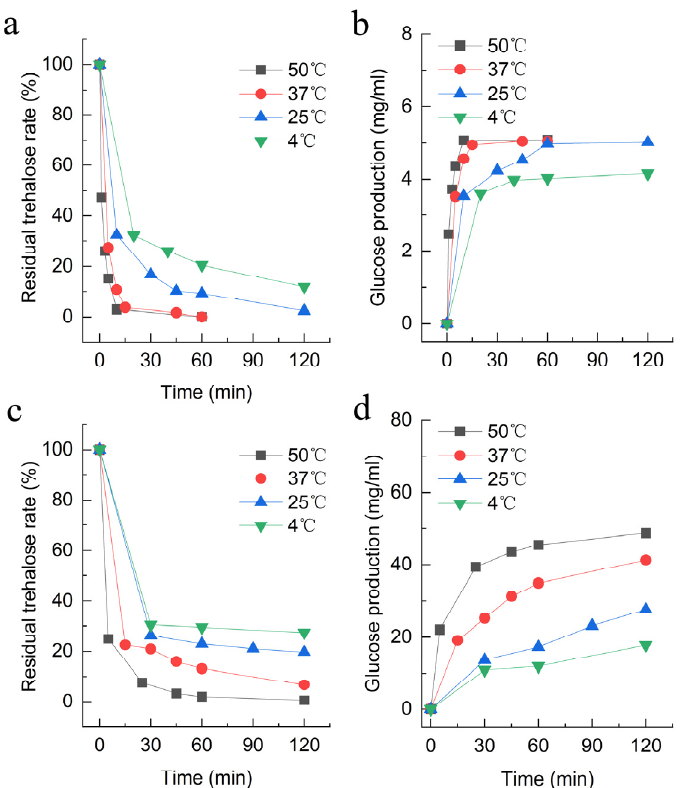
Figure 7. HPLC analysis of the time-course trehalose conversion by MpTre15A at the different reaction temperatures. The enzyme was incubated with 5 mg/mL ( a , b ) and 50 mg/mL trehalose ( c , d ), respectively, for up to 120 min to detect the consumption of trehalose ( a , c ) and the production of glucose ( b , d ).